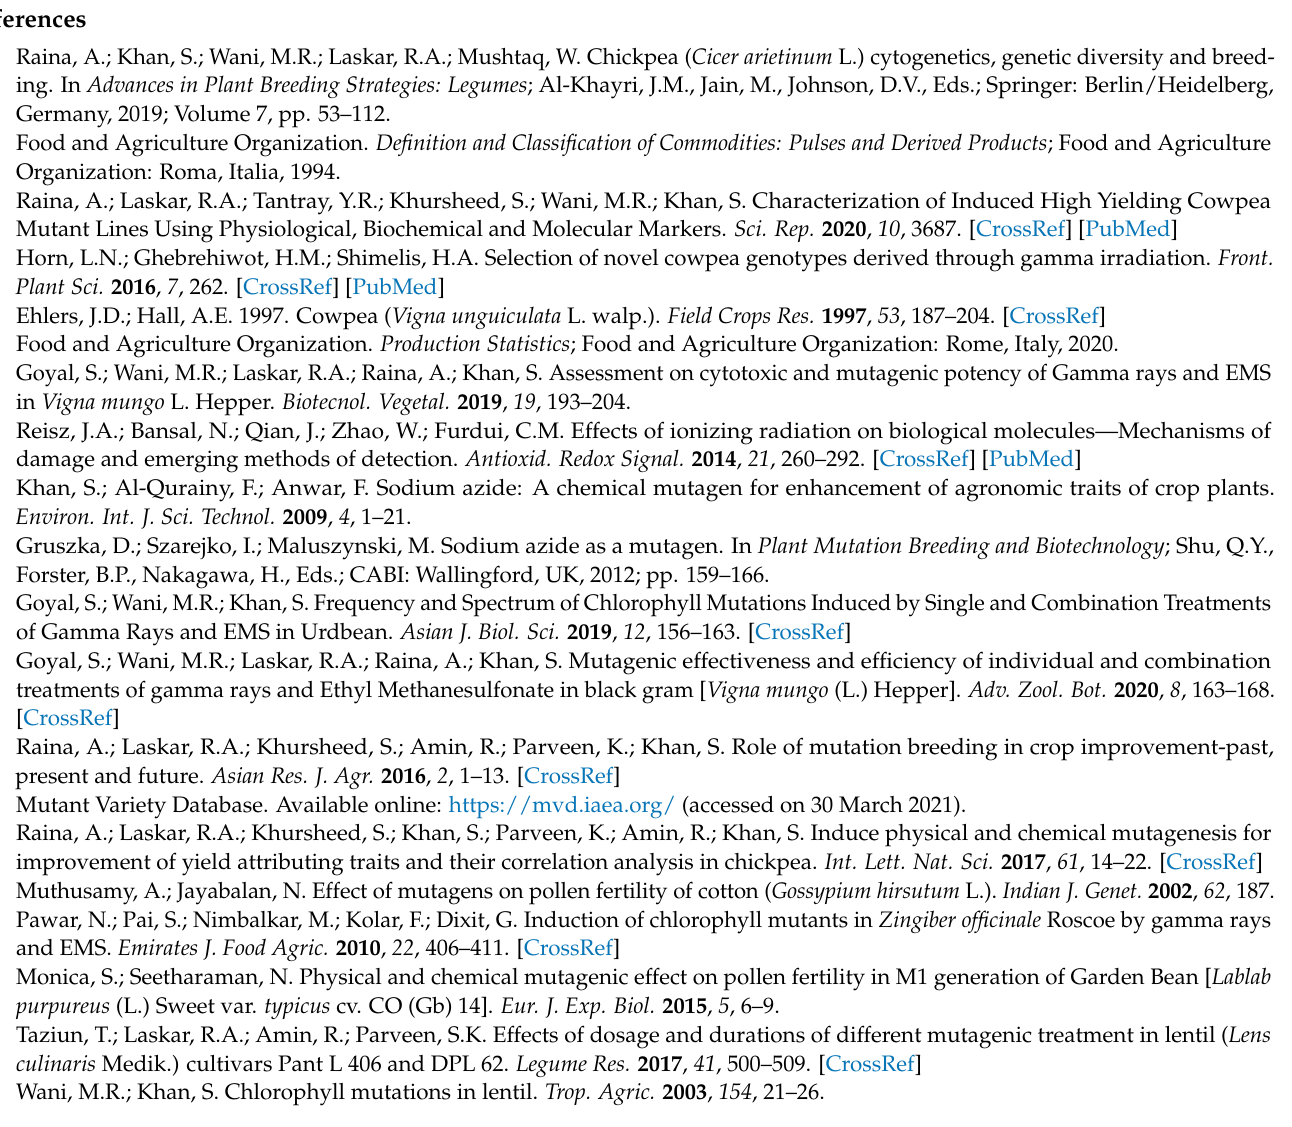
Figure S4. Comparative frequency and spectrum of induced morphological mutations in cowpea are based on the pooled values of two